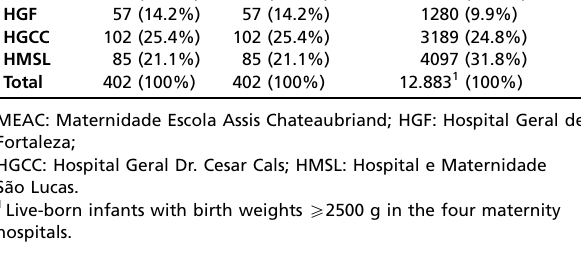
Table 2 - Characteristics of the hospitals included in the study during 2009.